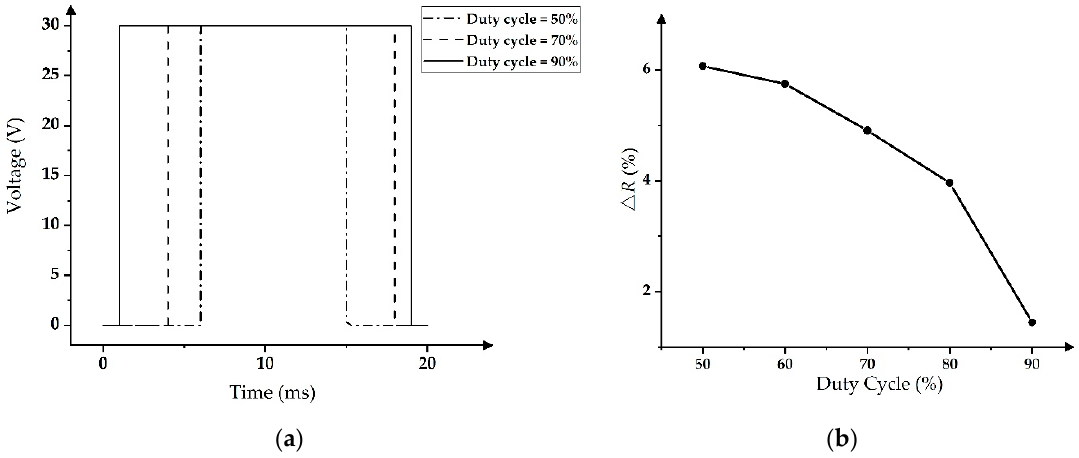
Figure 8. The pulse width modulation (PWM) driving waveform and its aperture ratio performance [14,30]. ( a ) The PWM driving waveform with different duty cycles. ( b ) Relationship between the duty cycle and △ R .